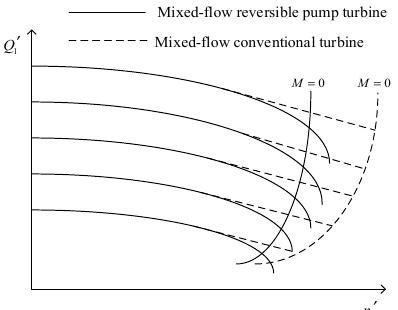
Figure 5. Comparison of operating characteristic curves between conventional turbine and pump turbine.